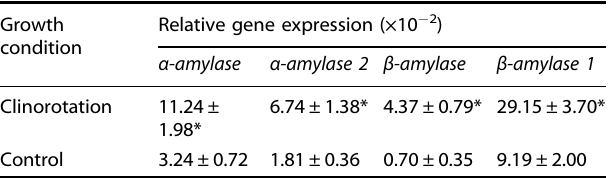
Table 3. Amylase gene expression in cotyledons ( n = 10).